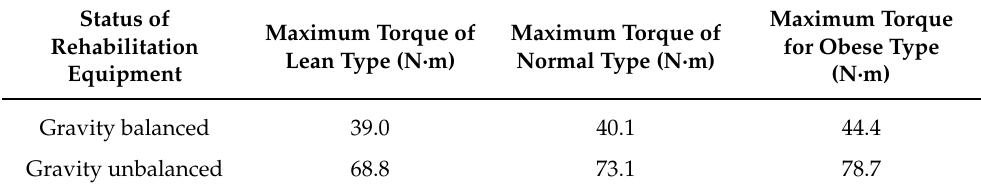
Table 9. Comparison of maximum torque during hip rehabilitation.